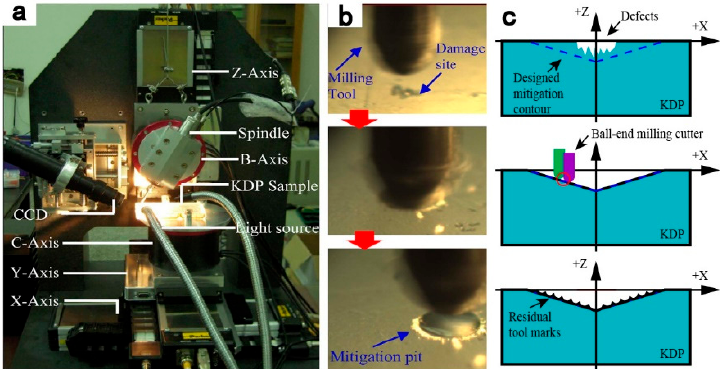
Figure 24. Micro-milling set-up developed for the repairment of damage on KDP crystal. ( a ) Overall configuration of the 5-axis vertical spindle machine tool; ( b ) The repairing process [105]; ( c ) Schematic of the generation process of tool marks in the micro ball-end milling repair process of KDP optics [107].